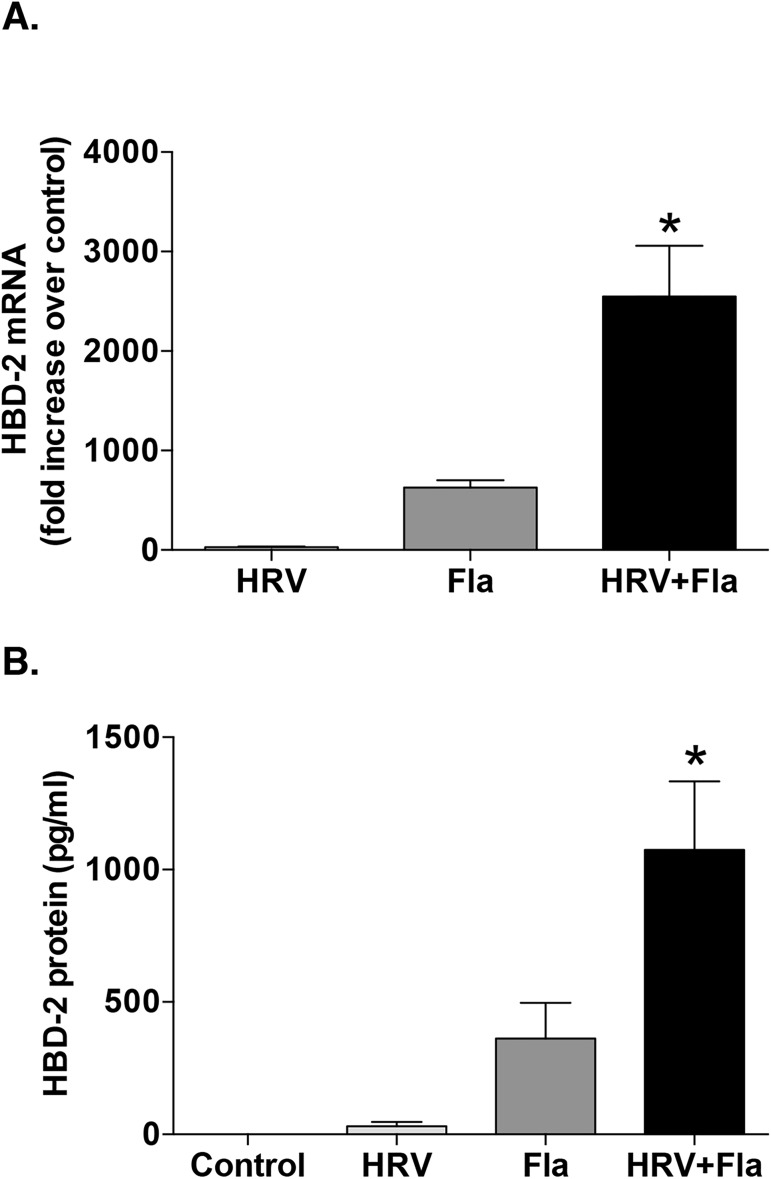
Synergy in human beta-defensin (HBD)-2 expression due to the combination human rhinovirus (HRV)-16 and flagellin (Fla) stimulation mimics HRV and live Pseudomonas aeruginosa (PA) co-infection in airway epithelial cells.A) HBD-2 mRNA (n = 8) and B) HBD-2 protein (n = 11) levels were determined after stimulation with HRV-16, 30 ng/ml of Fla, or the combination for 48 h in human bronchial epithelial (HBE) cells. Data are expressed as mean ± SEM (*p<0.05 between HRV+Fla and the sum of the values from each treatment alone).